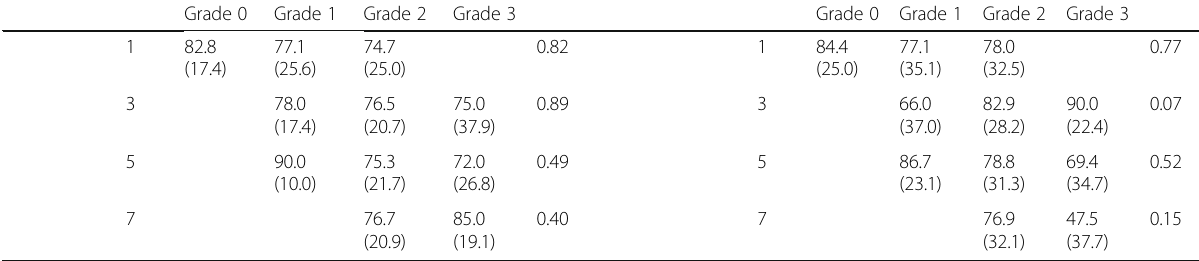
Table 2 QOL Scores by Maximum Grade Adverse Event Per Week (Continued)